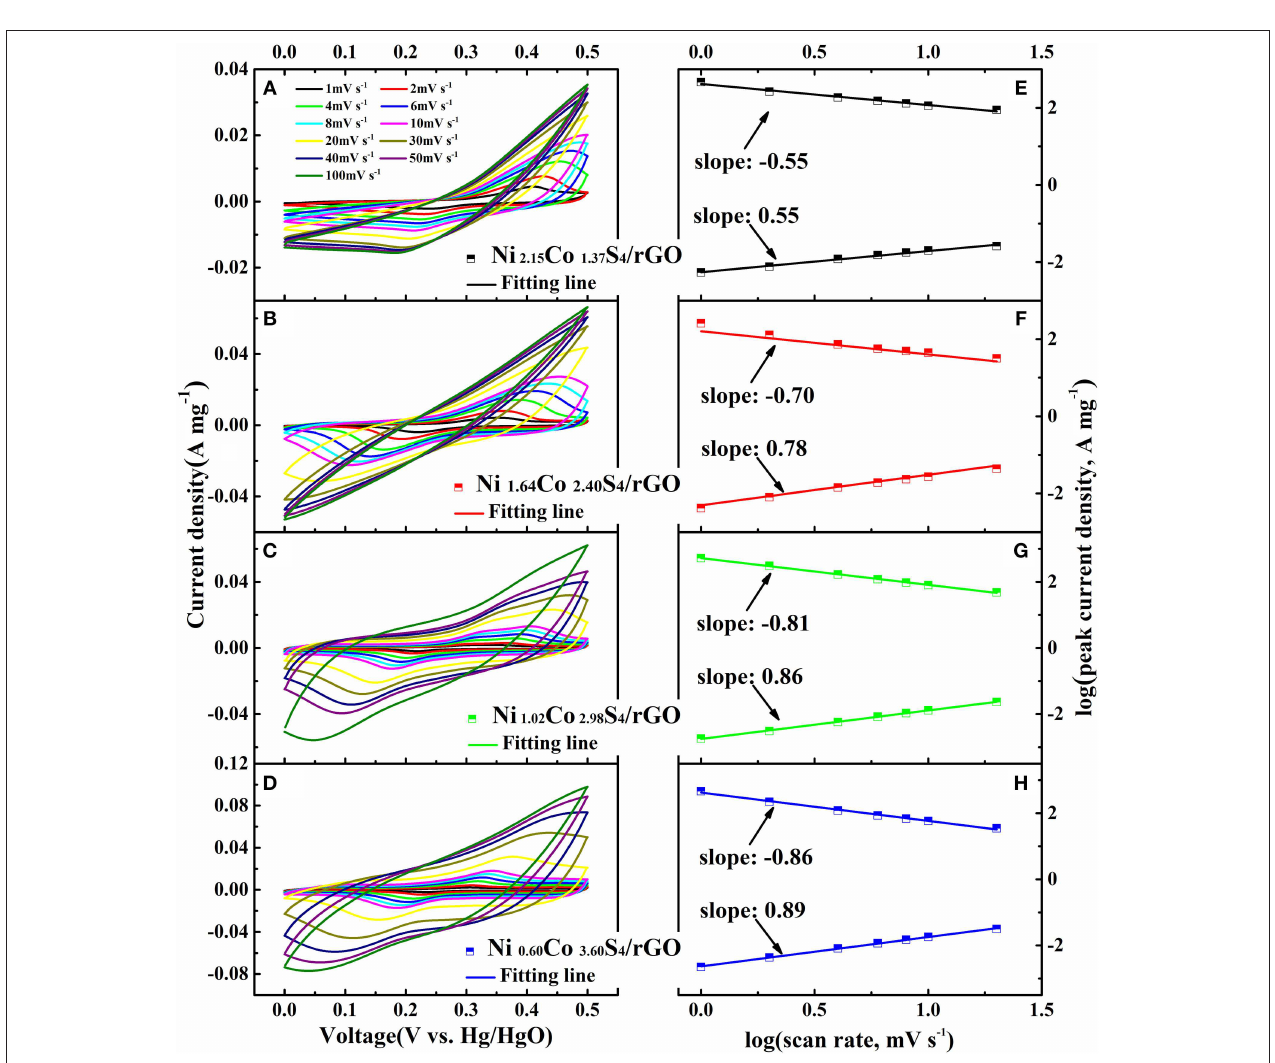
FIGURE 4 | Electrochemical properties of Ni x Co y S 4 /rGO composites at three-electrode cells. CV curves of Ni 2.15 Co 1.37 S 4 /rGO, Ni 1.64 Co 2.40 S 4 /rGO,